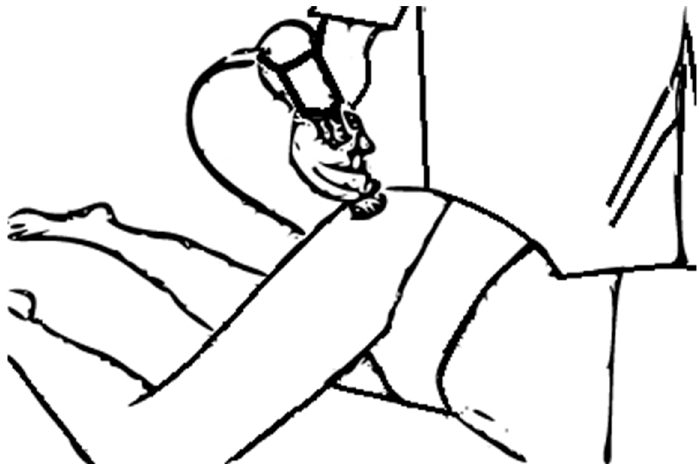
Figure 2. Schematic application of ESWT.